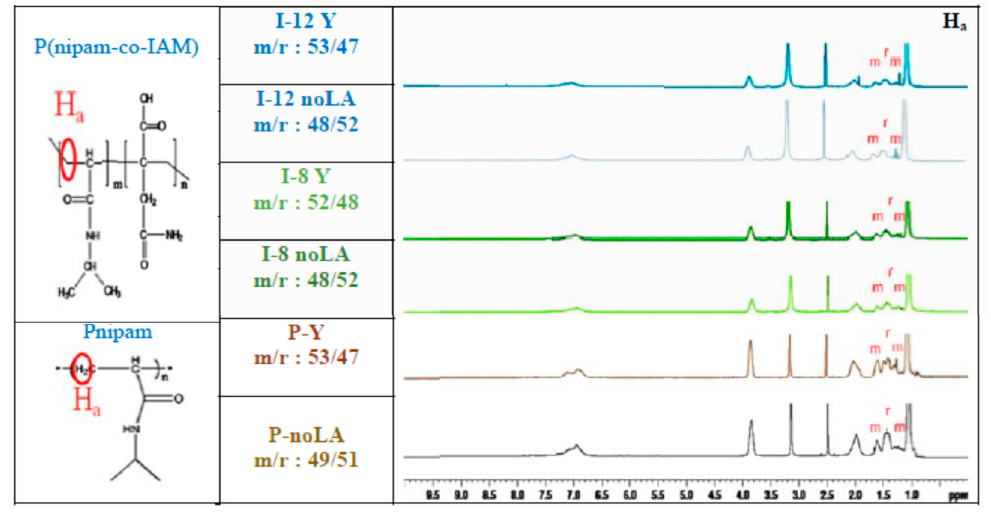
Figure 2. 1 H NMR spectra of Pnipam and poly(nipam-co-IAM) at 60 °C obtained with a 600 MHz NMR spectrometer.